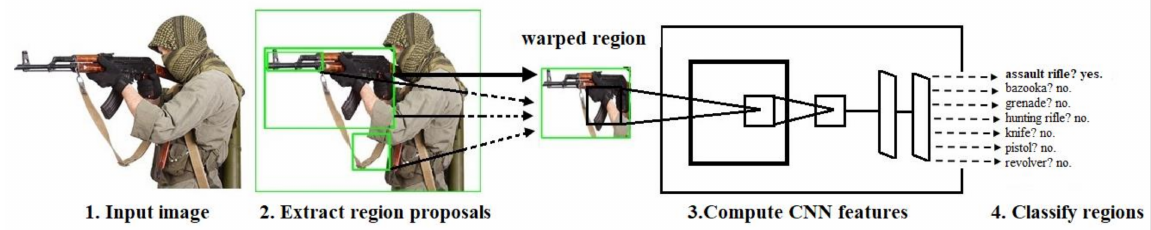
Figure 6. Region proposal